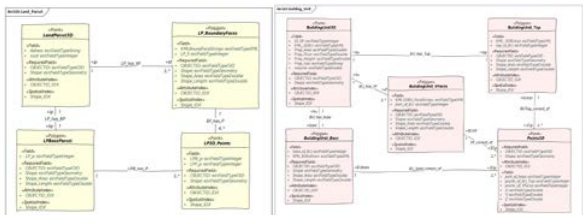
Figure 3. Proposed conceptual schema defining the structure of a 3D land parcel (left) and the 3D building unit (right) (Gkeli et al., 2019b)